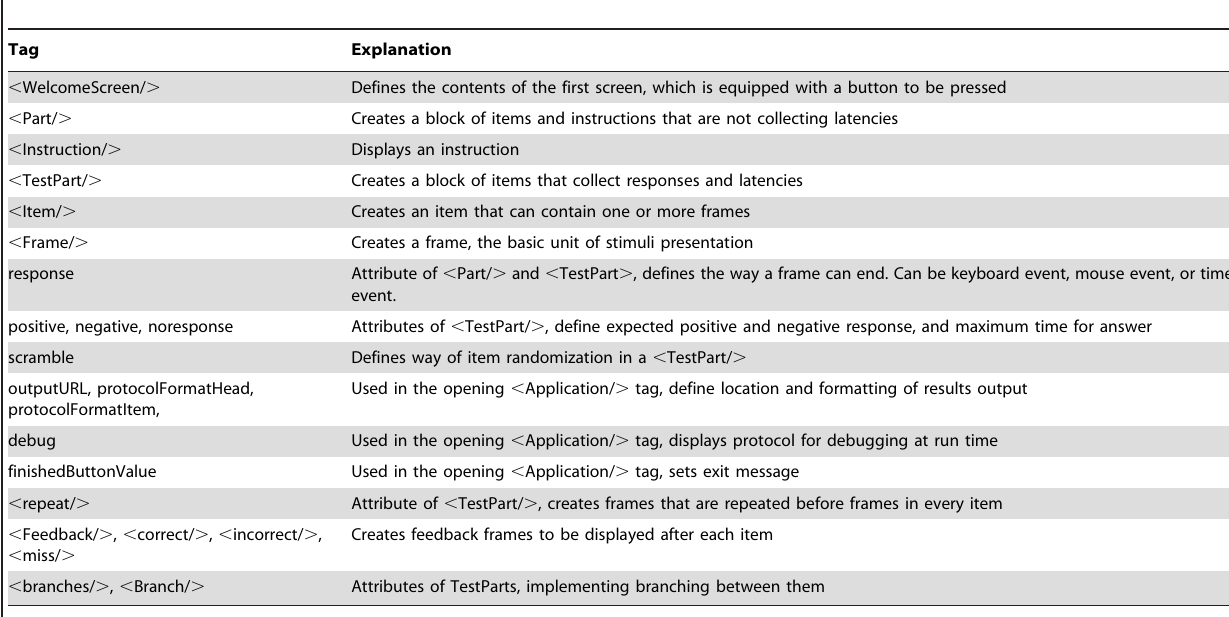
Table 1. Overview of main tags and attributes introduced by the ScriptingRT library.